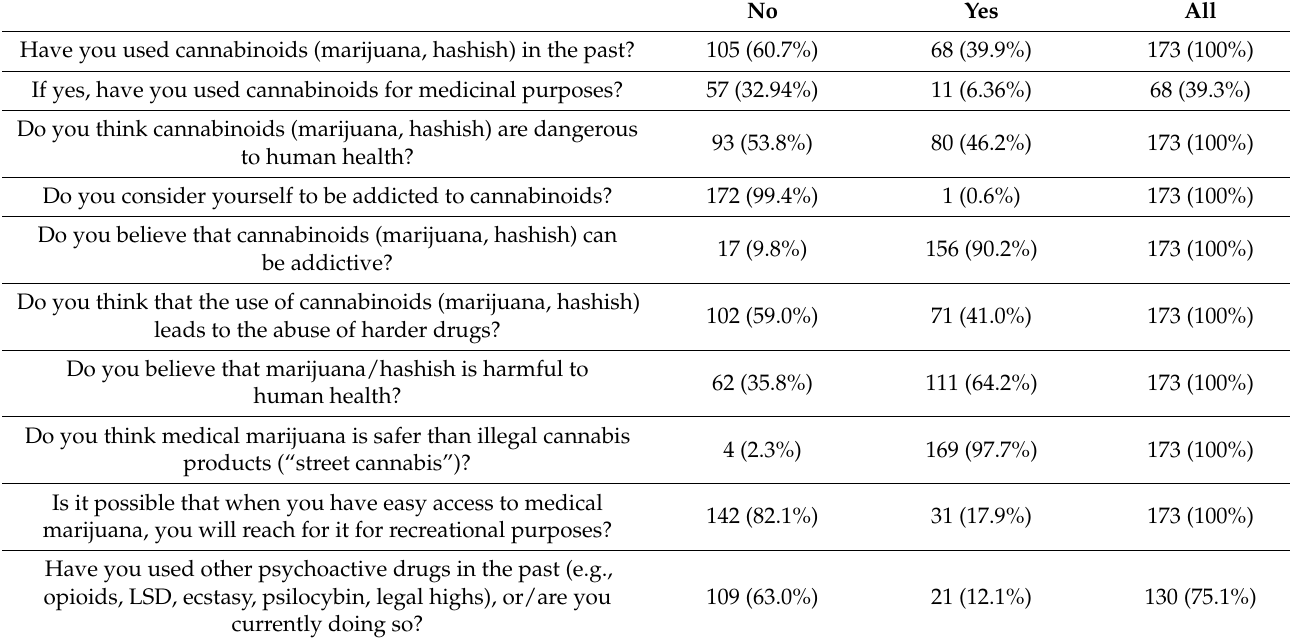
Table 5. Past use of cannabis and other psychoactive